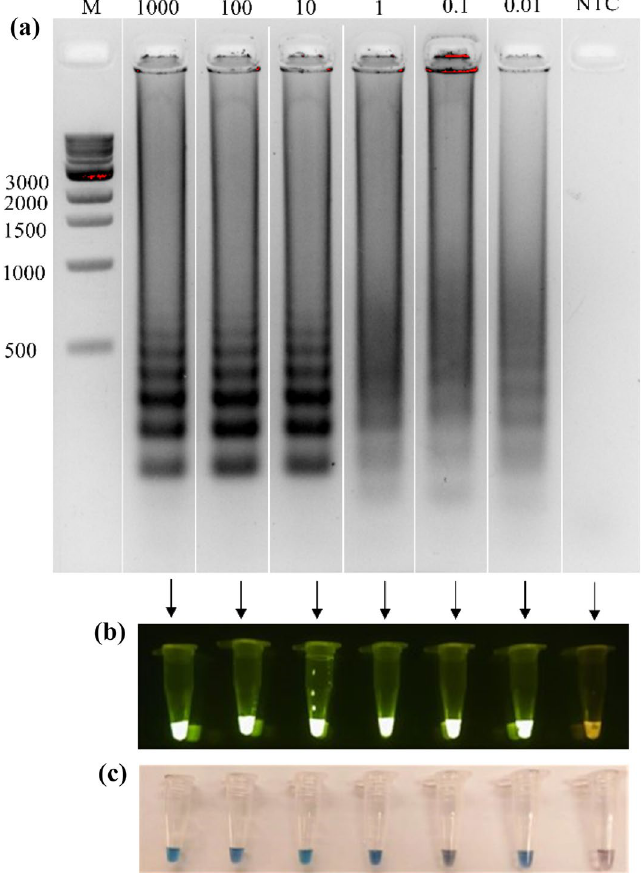
Figure 4. Sensitivity of LAMP amplification. ( a ) LAMP products visualized in 2% agarose gel containing different genomic DNA concentrations from S. aureus ranging from 1000 to 0.01 ng. DNA size marker is shown in leftmost lane; and a no template control (NTC) is shown in rightmost lane. “M” indicates “molecular-weight size marker.” ( b ) LAMP products with SYBR safe dye observed under blue light at different DNA concentrations. ( c ) LAMP products observed under naked eye with HNB dye with different DNA